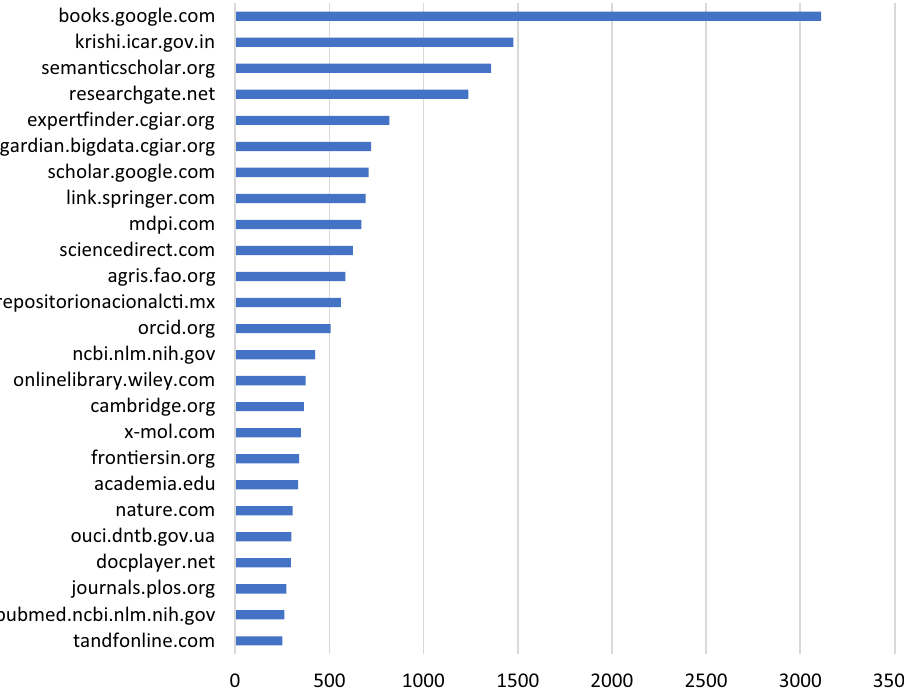
Figure 4. Frequency of top 25 domain names distributing CIMMYT’s climate-related outputs (CIMMYT website and repository